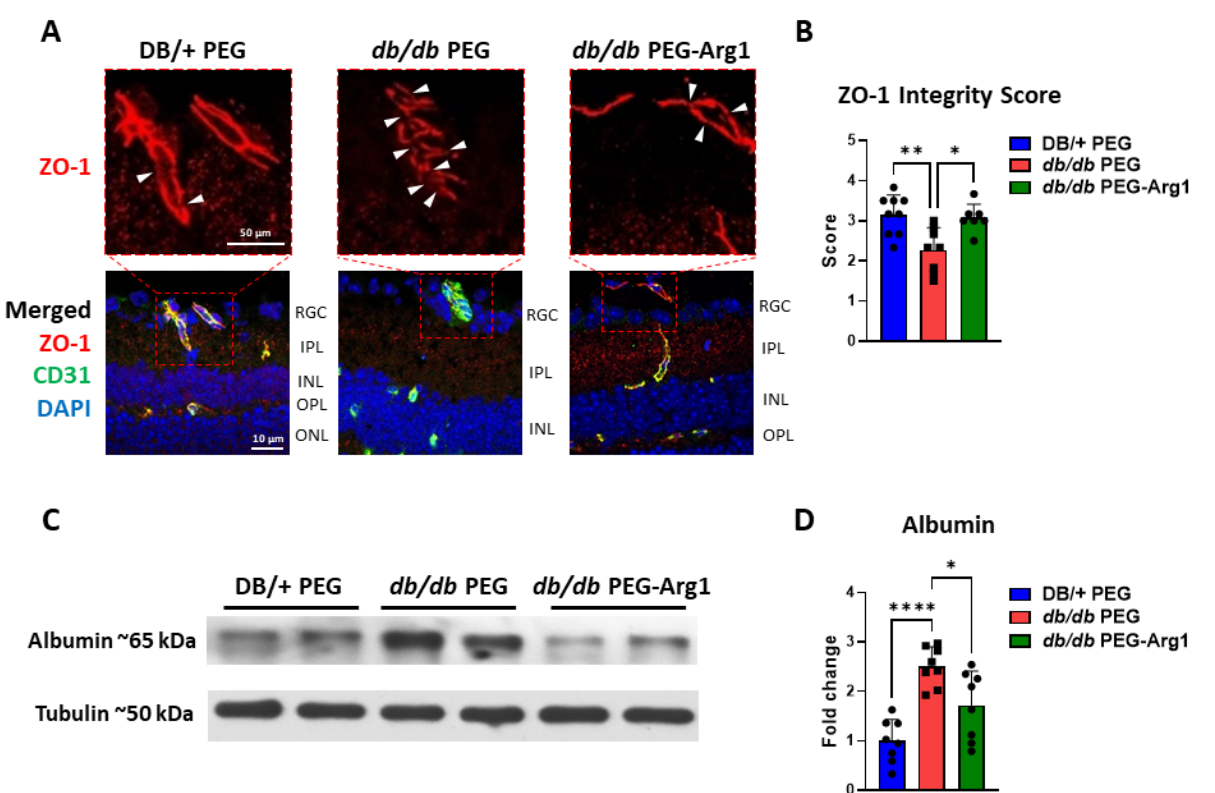
Figure 7. PEG-Arg1 treatment improves the blood–retinal barrier in db/db mice. ( A ) Representative immunofluorescent co-labeling of ZO-1 (tight junction protein) and CD31 (endothelial-specific marker) from frozen retina sections from PEG-treated DB/+ (lean control), PEG-treated db/db (obese, diabetic control), and PEG-Arg1-treated db/db mice, with the enlarged inset (red box) for ZO-1 staining showing tight junction breaks (white triangles). The co-localization of ZO-1 with CD31 demonstrates moderate restoration of the blood–retinal barrier (BRB) in db/db mice treated with PEG-Arg1. ( B ) Quantitative analysis of ZO-1 and CD31 immunofluorescent labeling represented as average ZO-1 continuity scores, showing a significant improvement in BRB continuity with PEG-Arg1 treatment. (* p < 0.05, ** p < 0.01) ( C ) Representative Western blots of retinal tissue albumin extravasation, demonstrating increased albumin extravasation in the PEG-treated control db/db mice compared with the lean controls. ( D ) PEG-Arg1 treatment significantly decreased albumin leakage in the retinas of db/db mice (n = 8/group, * p < 0.05 and **** p < 0.001). RGC: retinal ganglion cell layer; IPL: inner plexiform layer; INL: inner nuclear layer; OPL: outer plexiform layer; ONL: outer nuclear